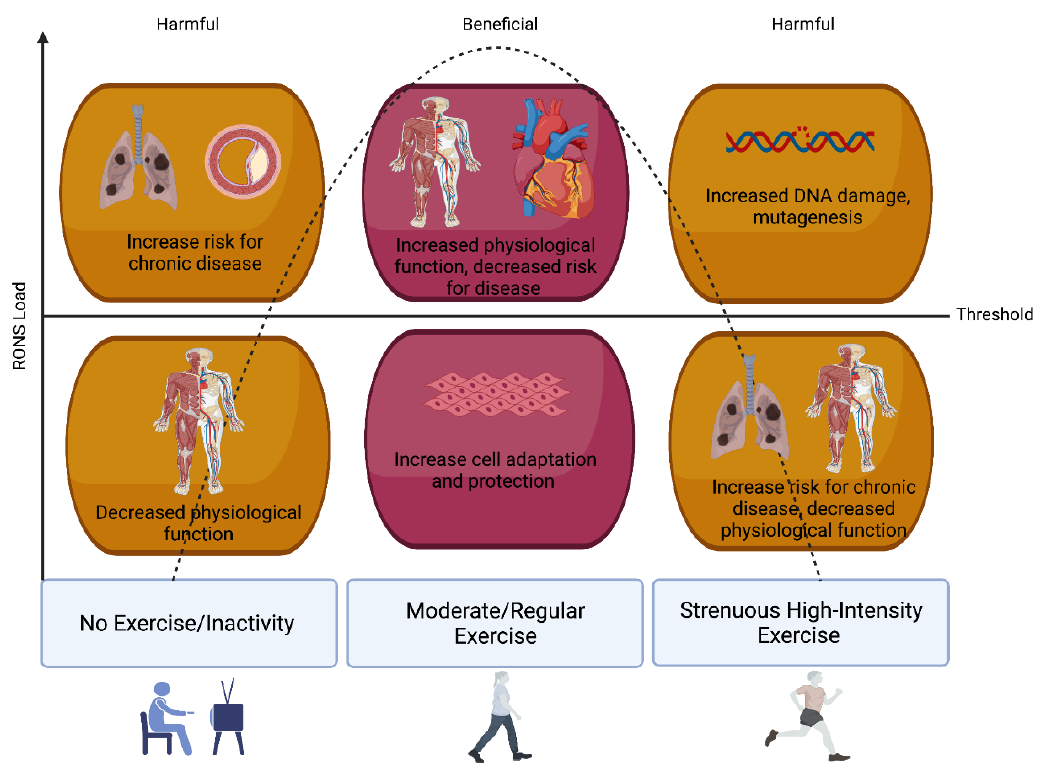
Figure 2. Exercise-induced RONS, Oxidative Stress, and Hormesis. The fundamental basis of the hormesis theory can be applied to exercise-induced RONS formation: low or transient increases in RONS, from moderate-intensity and regular exercise, activate signalling pathways that induce adaptive and protective responses. Whereas inactivity and/or sporadic strenuous/high-intensity exercise can lead to a RONS load that overwhelms antioxidant defences leading to oxidative stress, impaired physiological function, and an increased risk for chronic disease.